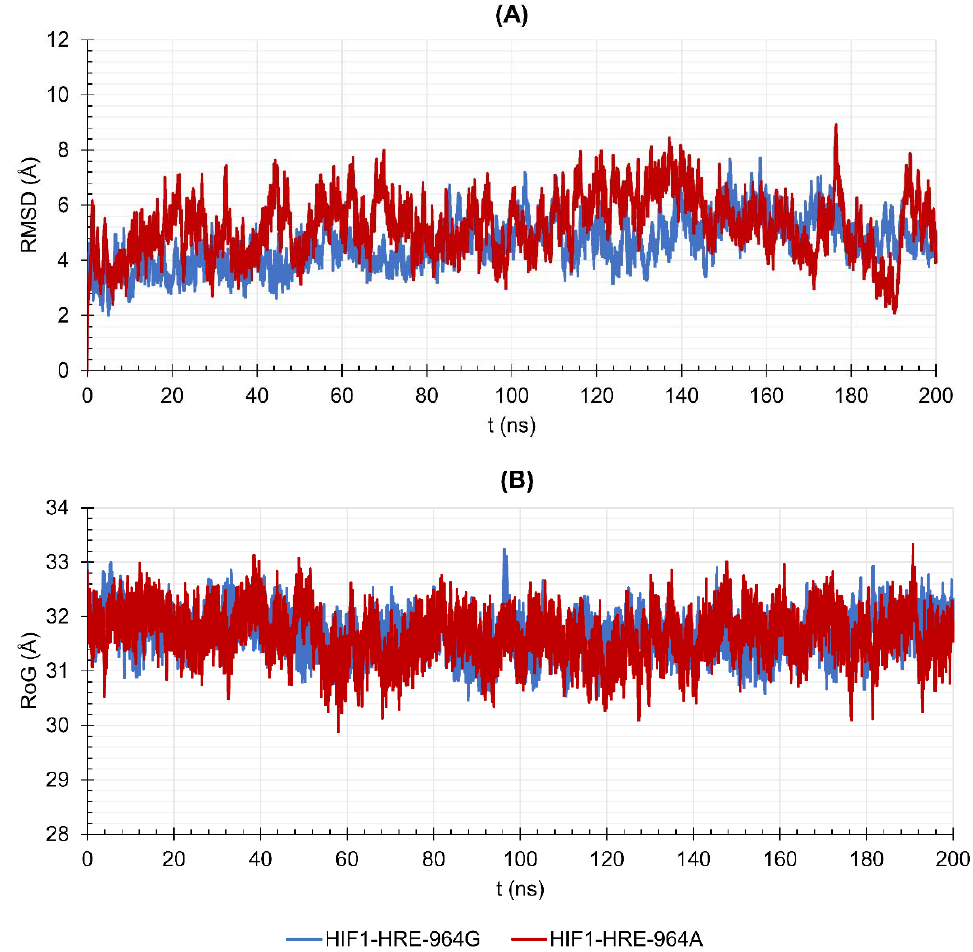
Figure 5. Values of ( A ) Root Mean Square Deviation (RMSD) and ( B ) Radii of Gyration (RoG) over 200 ns for the DNA double helix of HIF1-HRE complexes, according to the HLA-G − 964G > A polymorphism. Note: Author's own image.